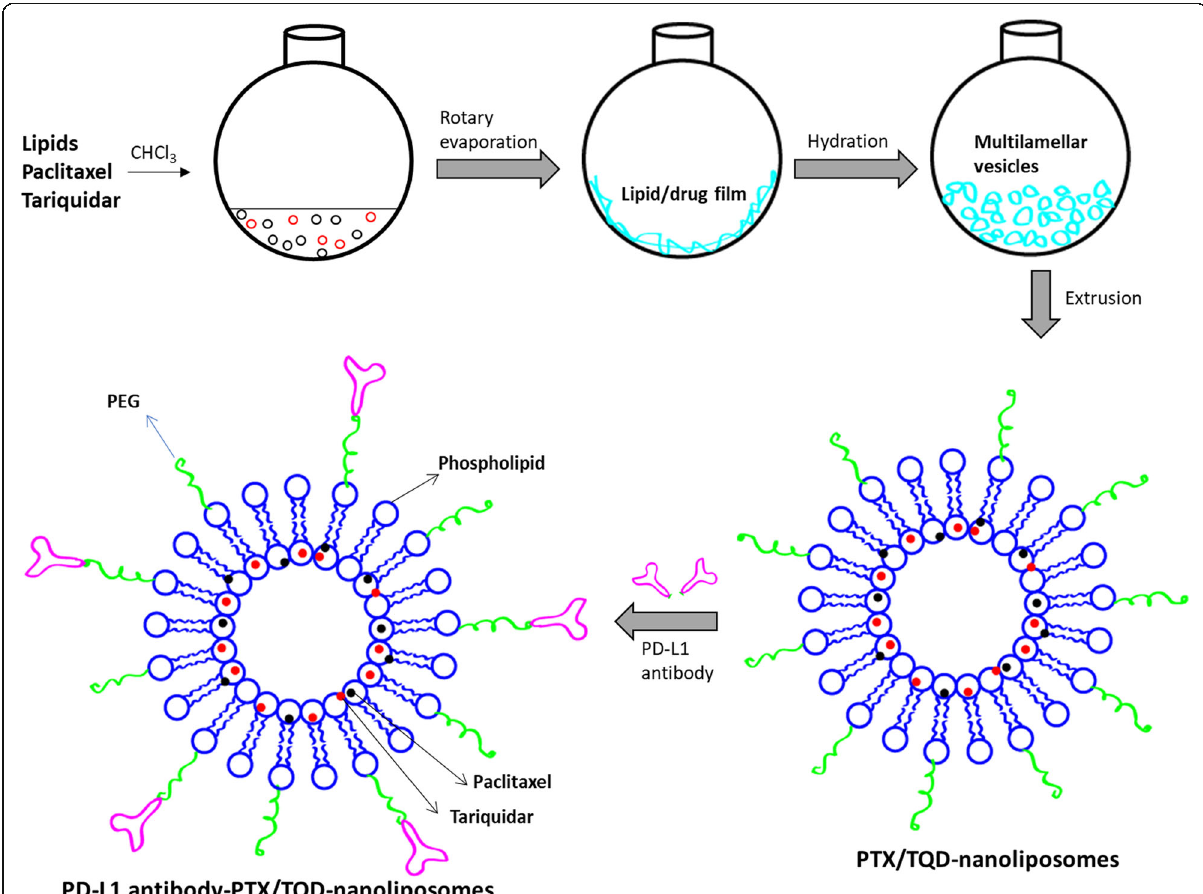
Fig. 1 Schematic illustrations of loading of paclitaxel and tariquidar in PD-L1 monoclonal antibody (mAb)-surface conjugated nanoliposomes. The liposome was prepared by hydration of thin-lipid film and sonicated to form the drug-loaded